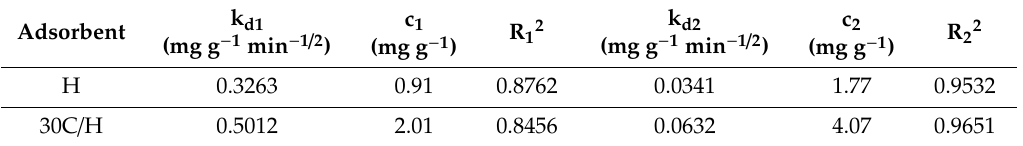
Figure 6. The intra-particle di ff usion of paracetamol on H and 30 / CH adsorbents (H—black triangles; 30C / H—red triangles). Table 6. Intra-particle di ff usion model